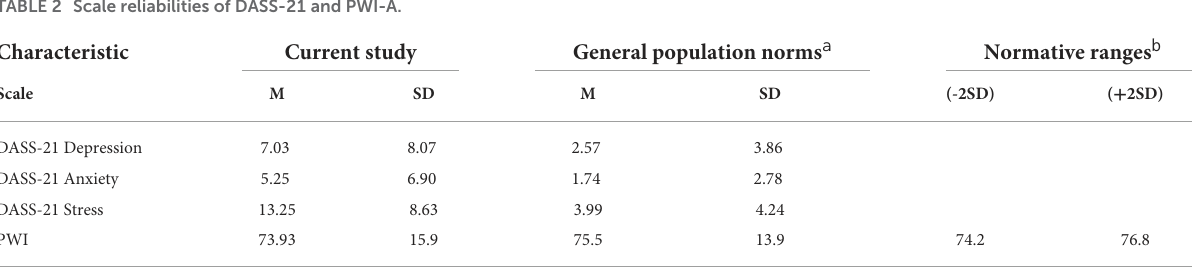
TABLE 2 Scale reliabilities of DASS-21 and